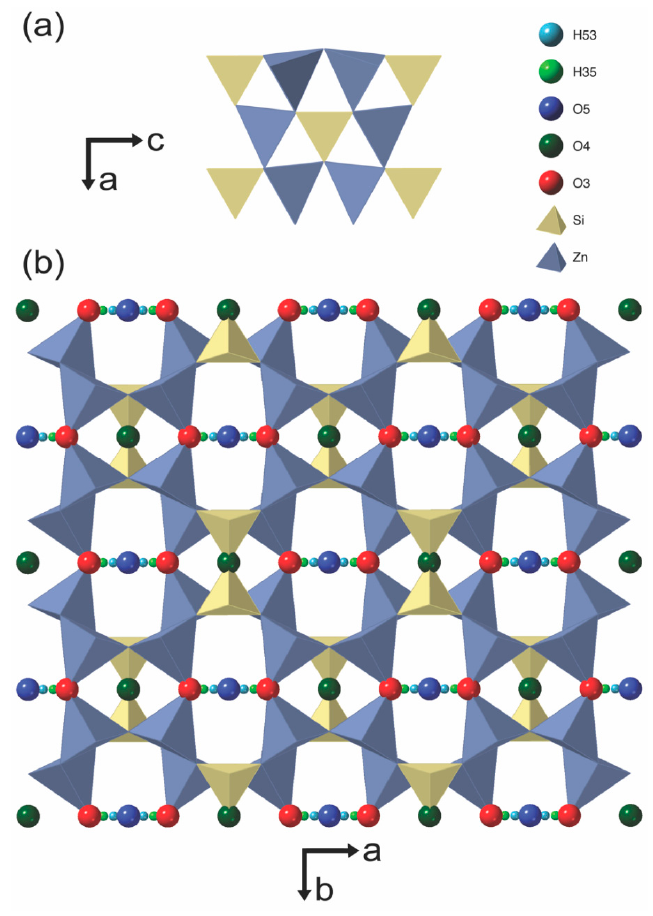
Figure 1. The crystal structure of hemimorphite. ( a ) Here, two zinc and one silicon tetrahedra comprise three-membered ring in (010) plane; ( b ) the structure of hemimorphite projected onto the a–b plane. Six-membered rings and eight-membered rings are in the a–b plane. Large cavities run along the c axis and contain H 2 O. The corrugated layers of three-membered rings are also apparent in this projection (modified from Hill, et al., 1977 [8]).